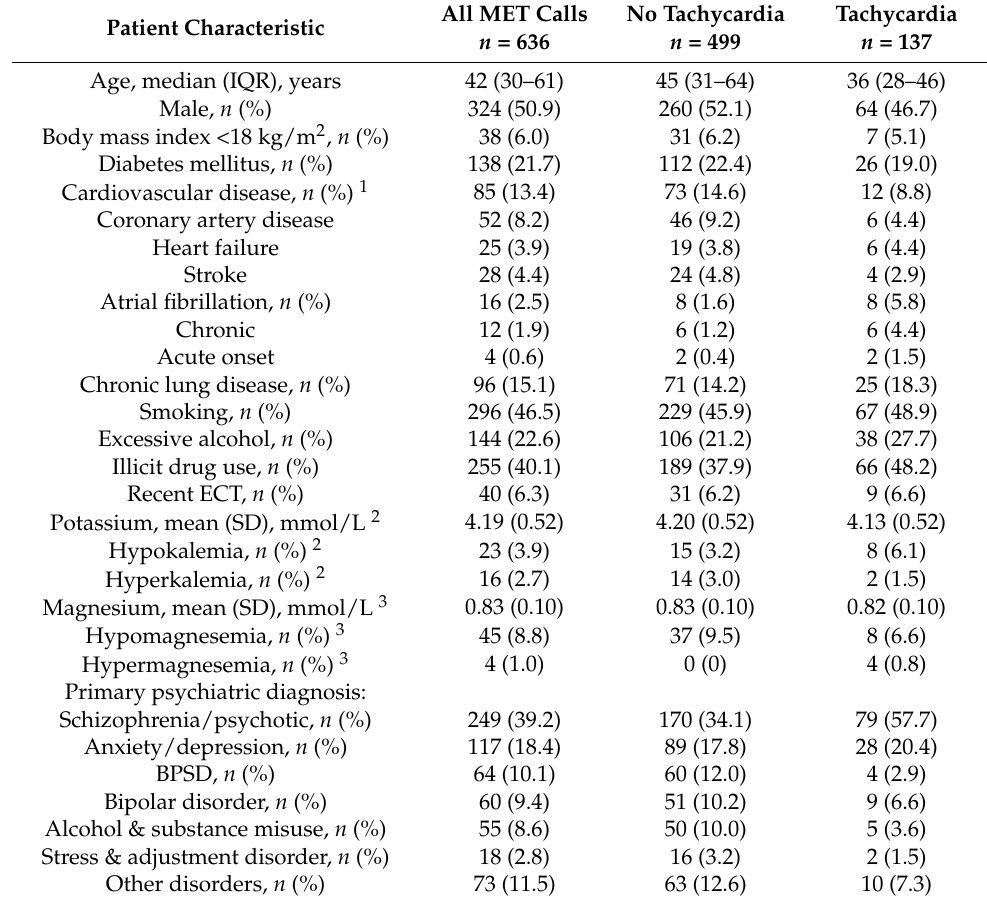
Table 1. Characteristics of patients experiencing Medical Emergency Team calls for severe tachycar-